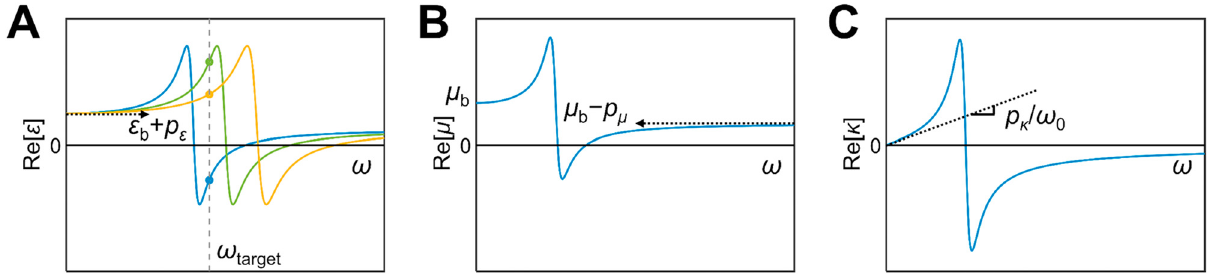
Figure1: Lorentzoscillatormodelsofeffectiveconstitutiveparameters.(A)Effectiveelectricpermittivity,whichconvergesto ε b + p ε atverylow frequency. By tuning the resonance frequency, effective permittivity can be controlled from highly-negative to highly-positive values (blue, yellow, green curves). Damping factor, γ , is assumed as ω 0 /10. Controllability based on adjusting resonance frequency can be applied to magnetic permeability and chirality parameter as well. (B) Effective magnetic permeability, which converges to μ b − p μ at high frequency regime. (C) Effective chirality parameter, which linearly increases as frequency increases with the slope of p κ / ω 0 at low